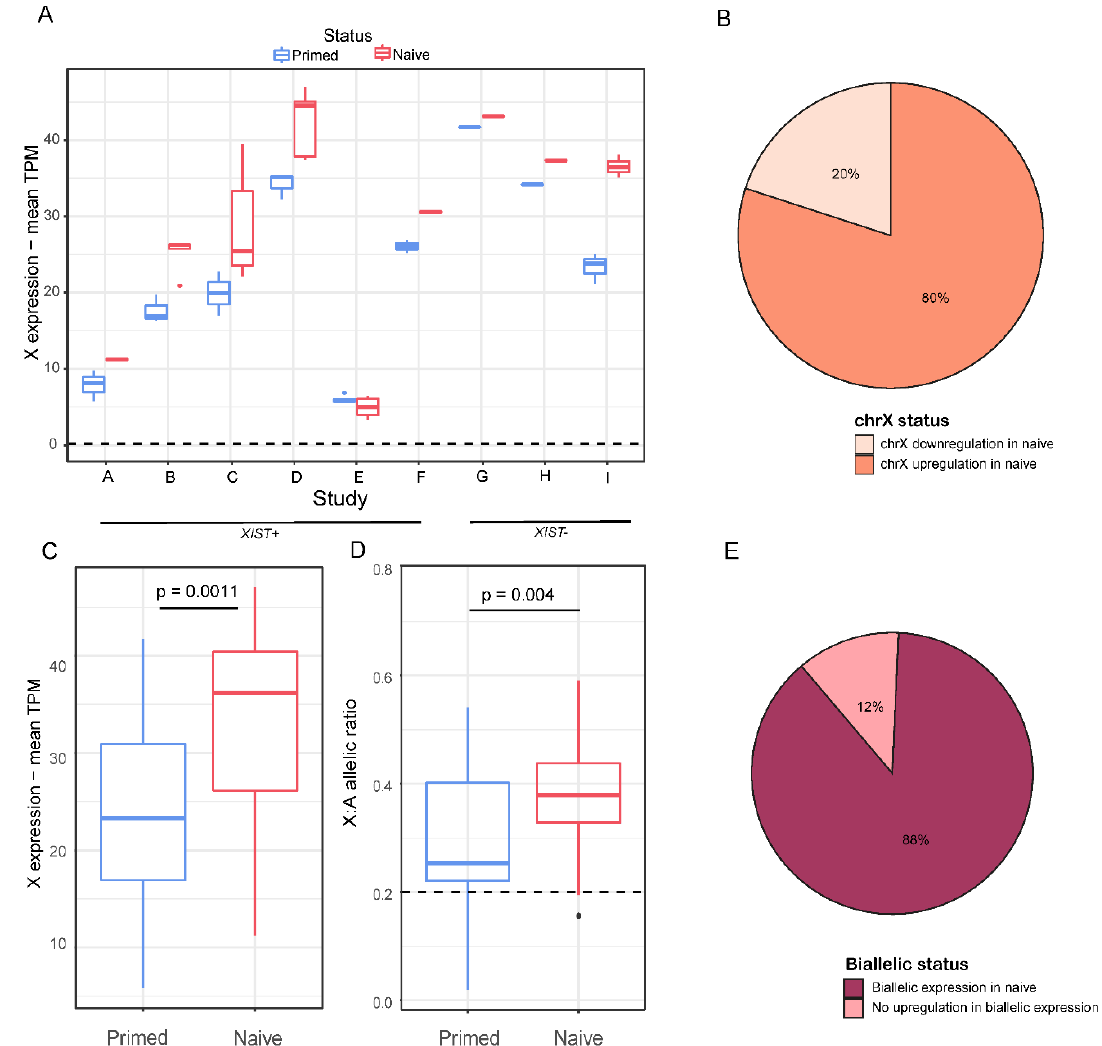
Figure 2. Changes in gene and allelic expression in chromosome X. ( A ) Average TPM expression of genes in chromosome X of primed (blue) and naïve (red) hESCs across 9 different studies. Whiskers and dots were calculated as mentioned in the legend to Figure 1. ( B ) Distribution of X-linked gene expression variations between naïve samples and their primed counterparts. ( C ) Average TPM expression of genes on chromosome X of primed (blue) and naïve (red) hESCs. p -value was calculated by a paired t -test. ( D ) Average X:autosomes allelic ratio of primed and naïve cells. p -value was calculated by a paired t -test. ( E ) Distribution of allelic expression variation across all naïve